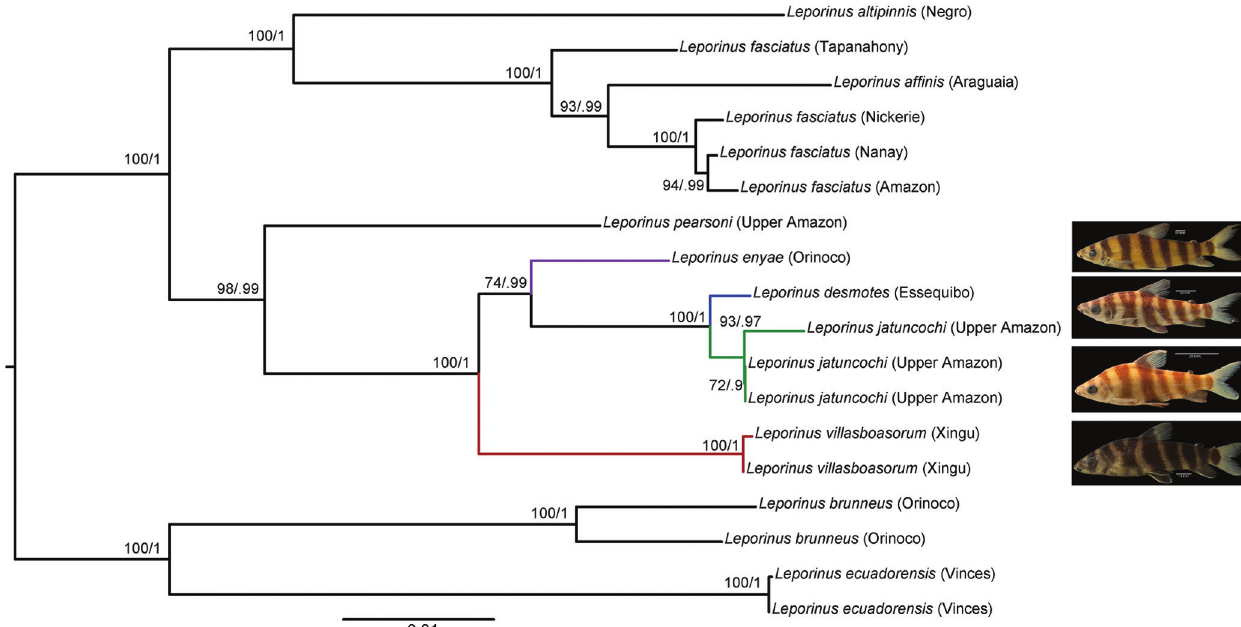
Fig. 5. Phylogenetic relationships within the Leporinus desmotes species complex showing the ML tree. Node values represent bootstrap support and posterior probabilities,